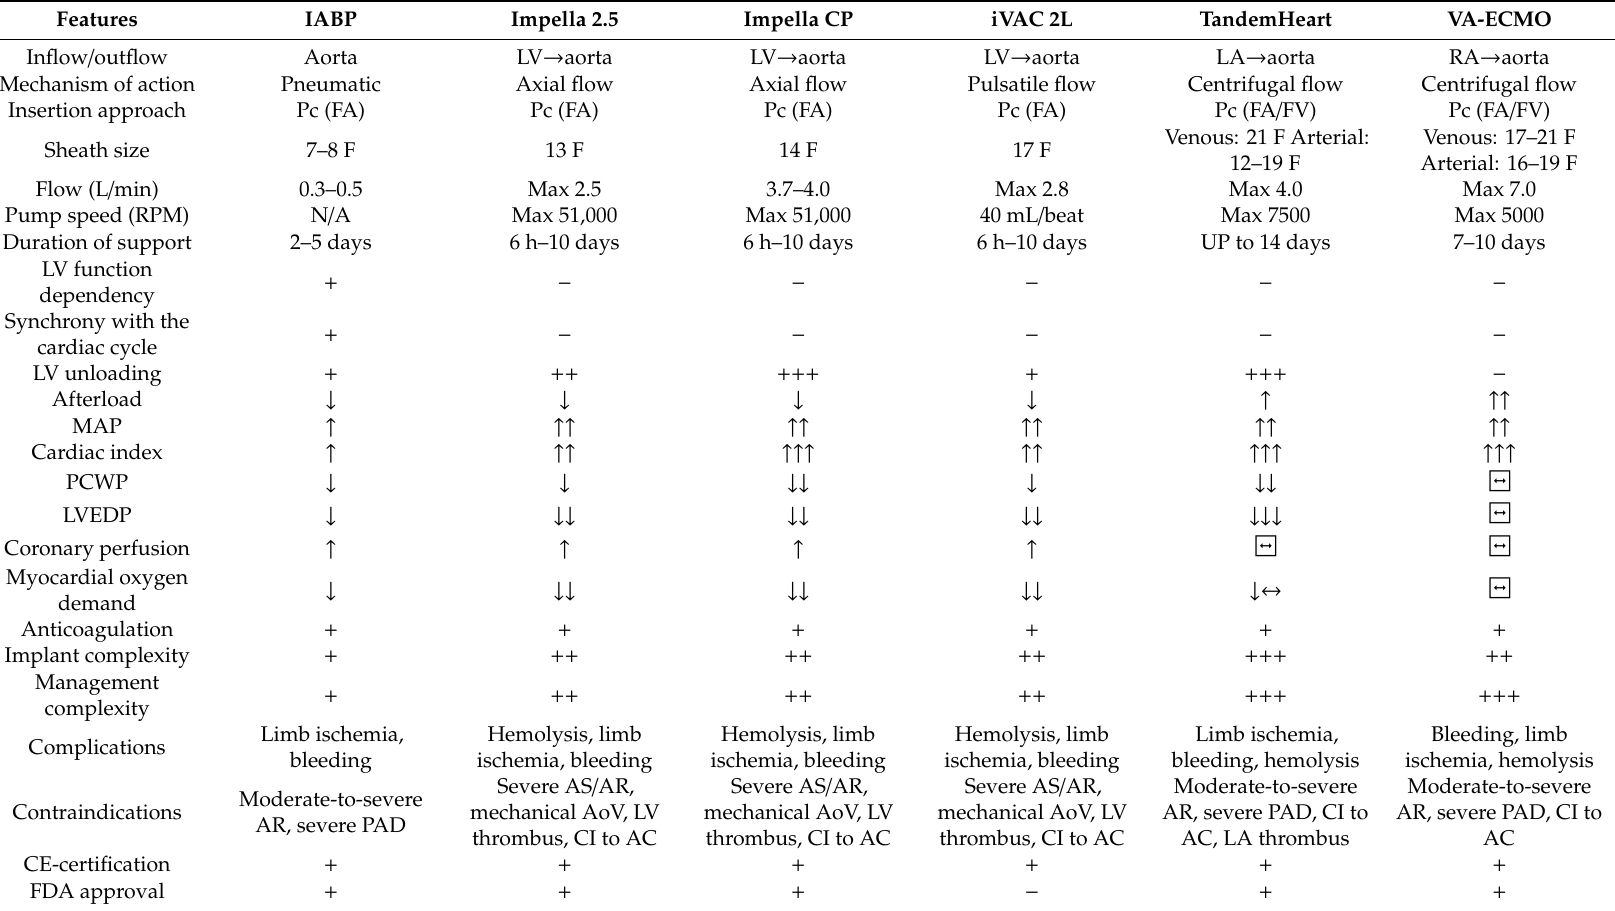
Table 2. Comparison of Technical and Clinical Features of Contemporary Percutaneous Mechanical Circulatory Support